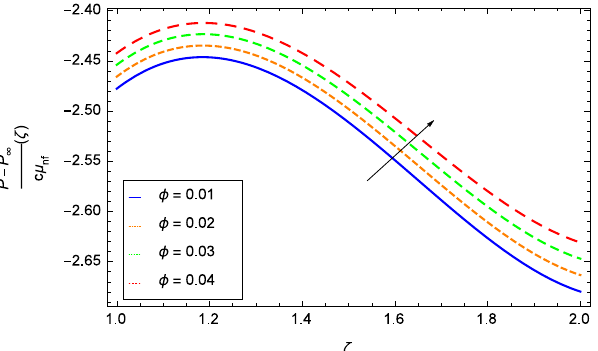
Figure 14. Non-dimensional Pressure P − P ∞ Pr = 6.80 and various values of φ (CuO-H 2 O).